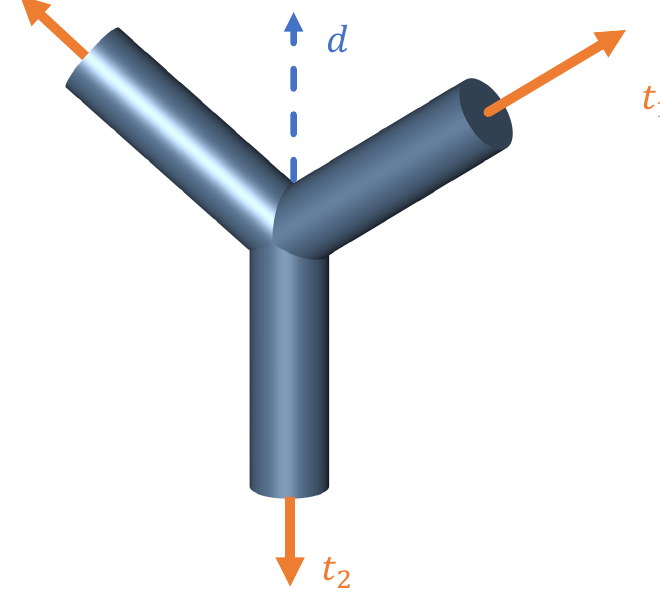
Figure 10. An example of truss-like